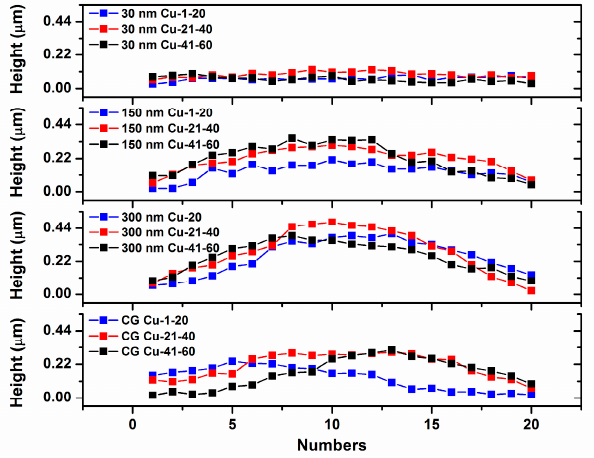
Figure 4. The values of the h pile-up around the three indenter edges in the 30 nm Cu, 150 nm Cu, 300 nm Cu, and CG Cu.